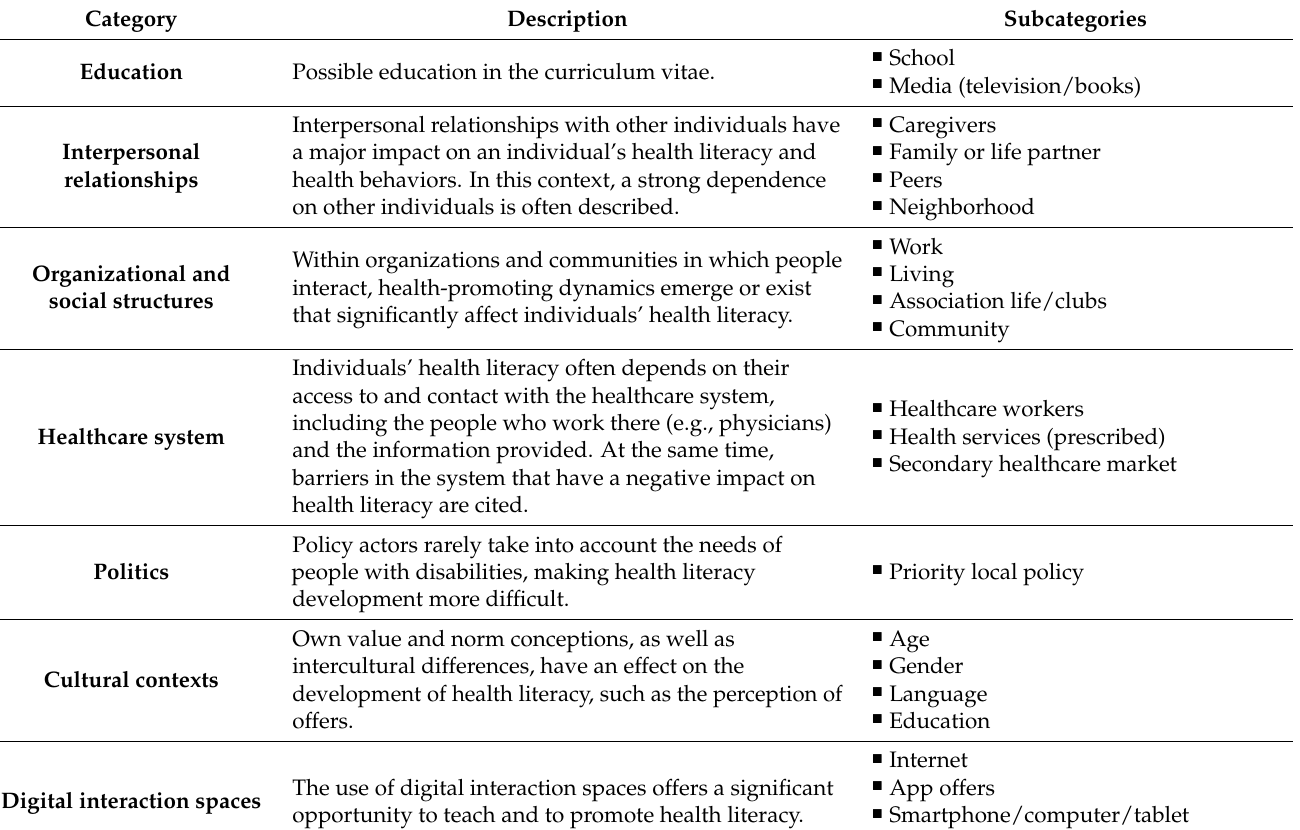
Table 1. Levels of social context in people with intellectual disabilities. Category Description Subcategories Education